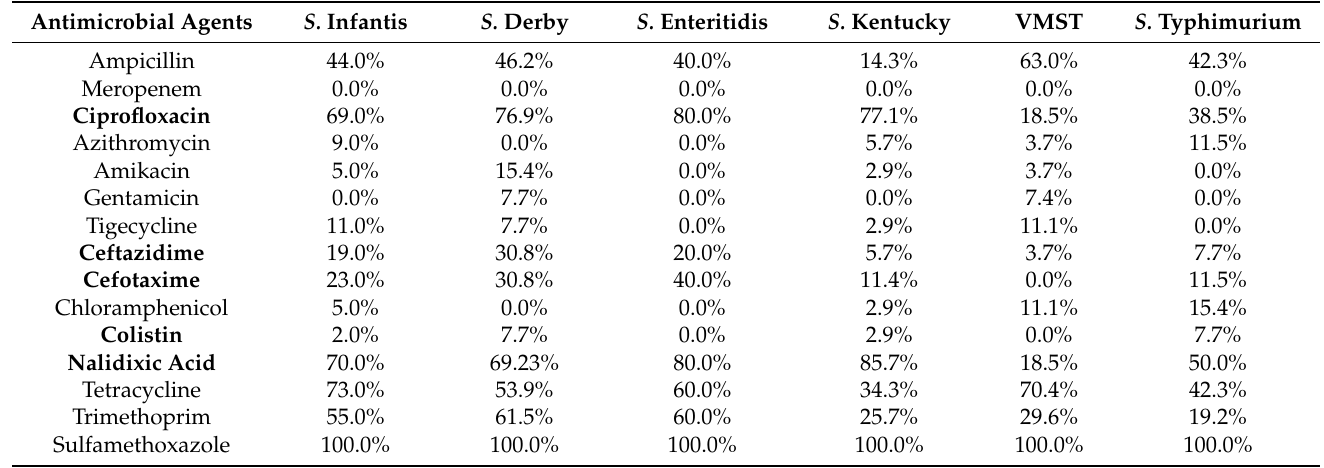
Table 2. Resistance to single antimicrobial agents for the serotypes of FA strains. In bold are the highest priority critically important